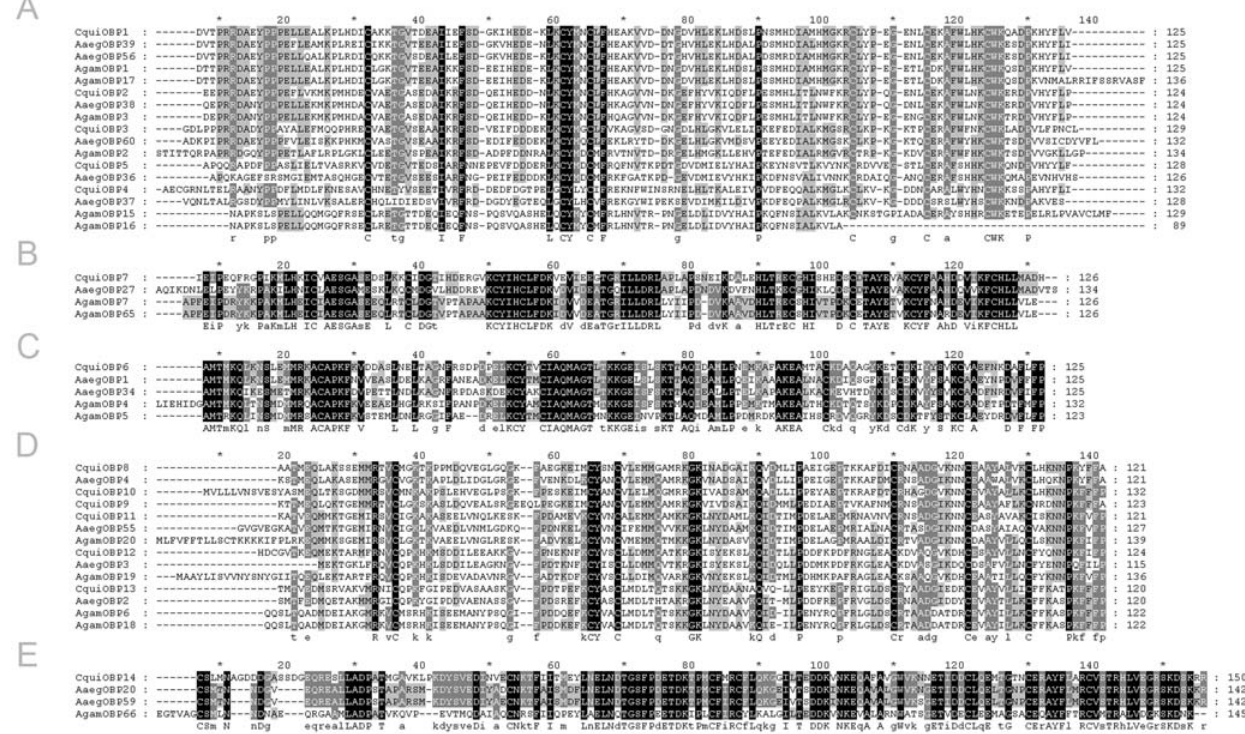
Figure 3. Amino acids alignments of five groups of mosquito OBPs. (A) OS-E/OS-F-like OBPs; (B) PBPRP1-like OBPs; (C) LUSH-like OBPs; (D) OBP19a-like OBPs; (E) PBPRP4-like OBPs. Residues conservation is indicated by different levels of shading: dark grey: 100% conservation; medium gray: 80% conservation; light gray: 60% conservation. doi:10.1371/journal.pone.0006237.g003 PLoS ONE |